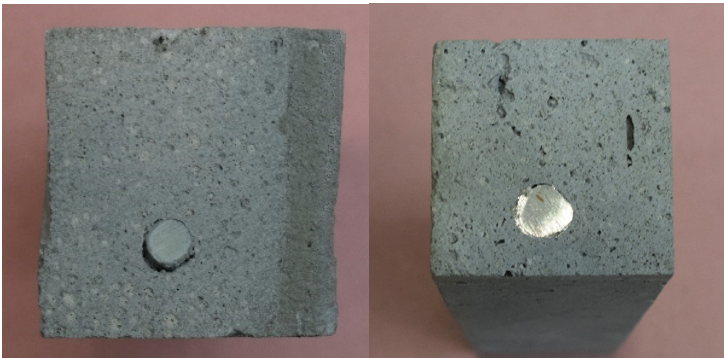
Figure 16. Bond between mortar and rebar: glass fiber ( left ), steel ( right ).